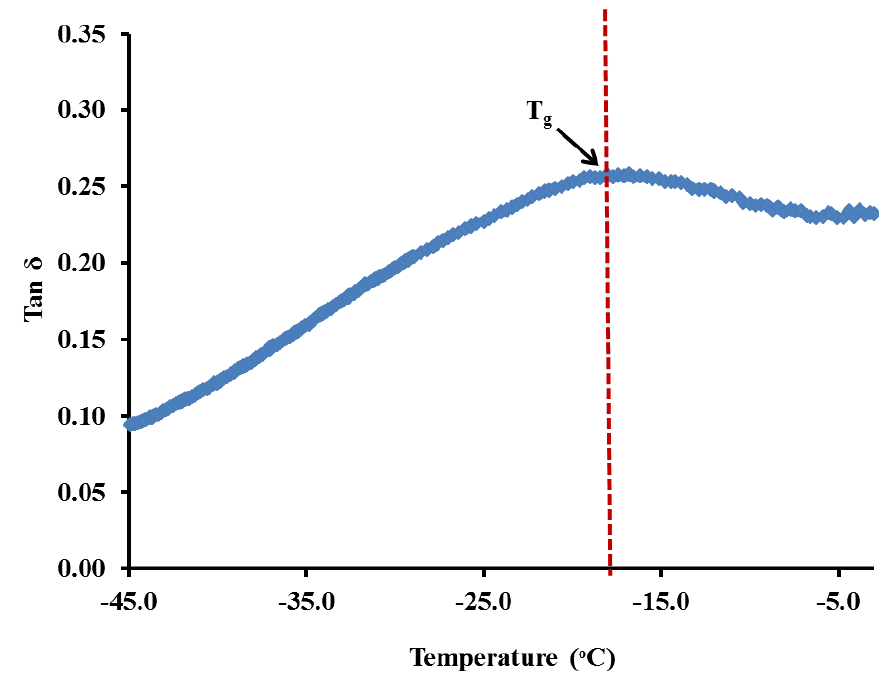
Figure 6. DMA spectrum for the pure CMC biopolymer